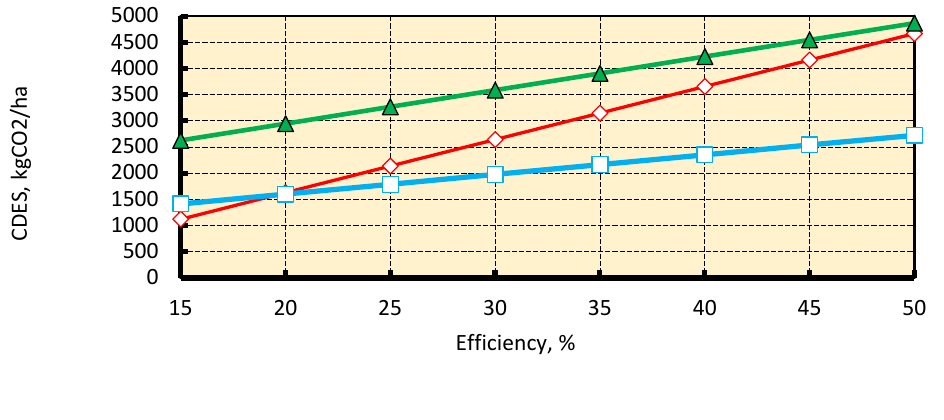
Figure 9. Carbon dioxide